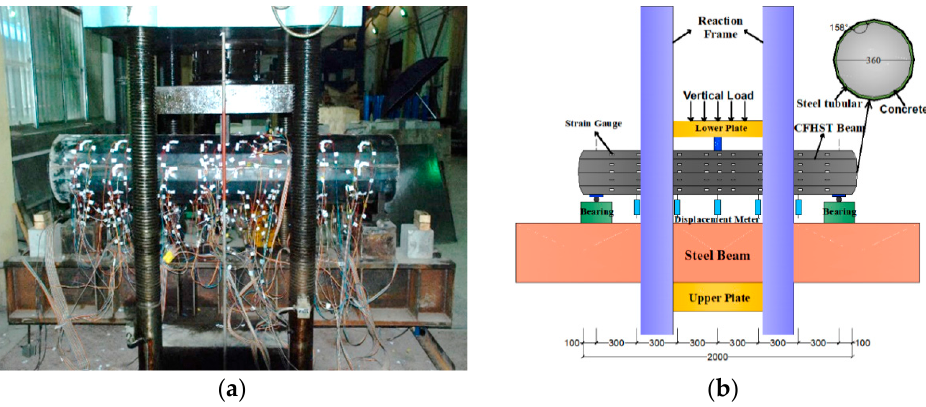
Figure 4. Loading devices. ( a ) Test device; ( b ) Detail drawing of device dimensions.